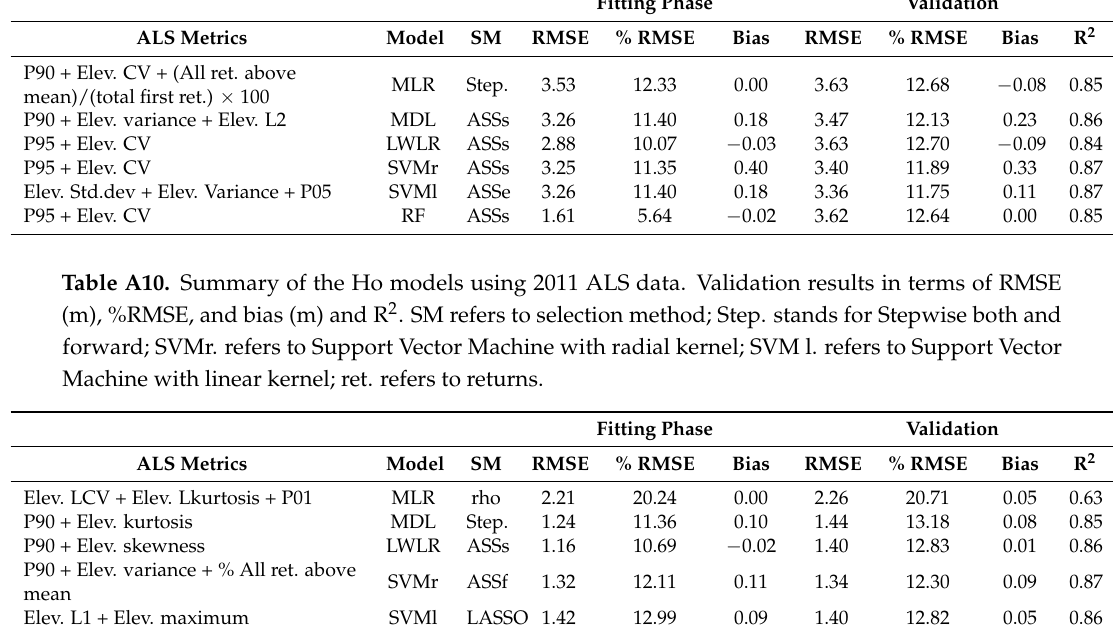
P90 + Elev. variance + Elev. L2